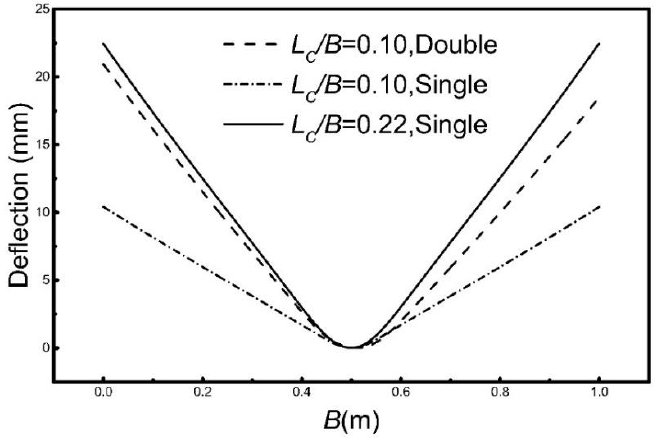
Figure 21. S B 1 -S B 1 section flexure lines for different heating conditions.